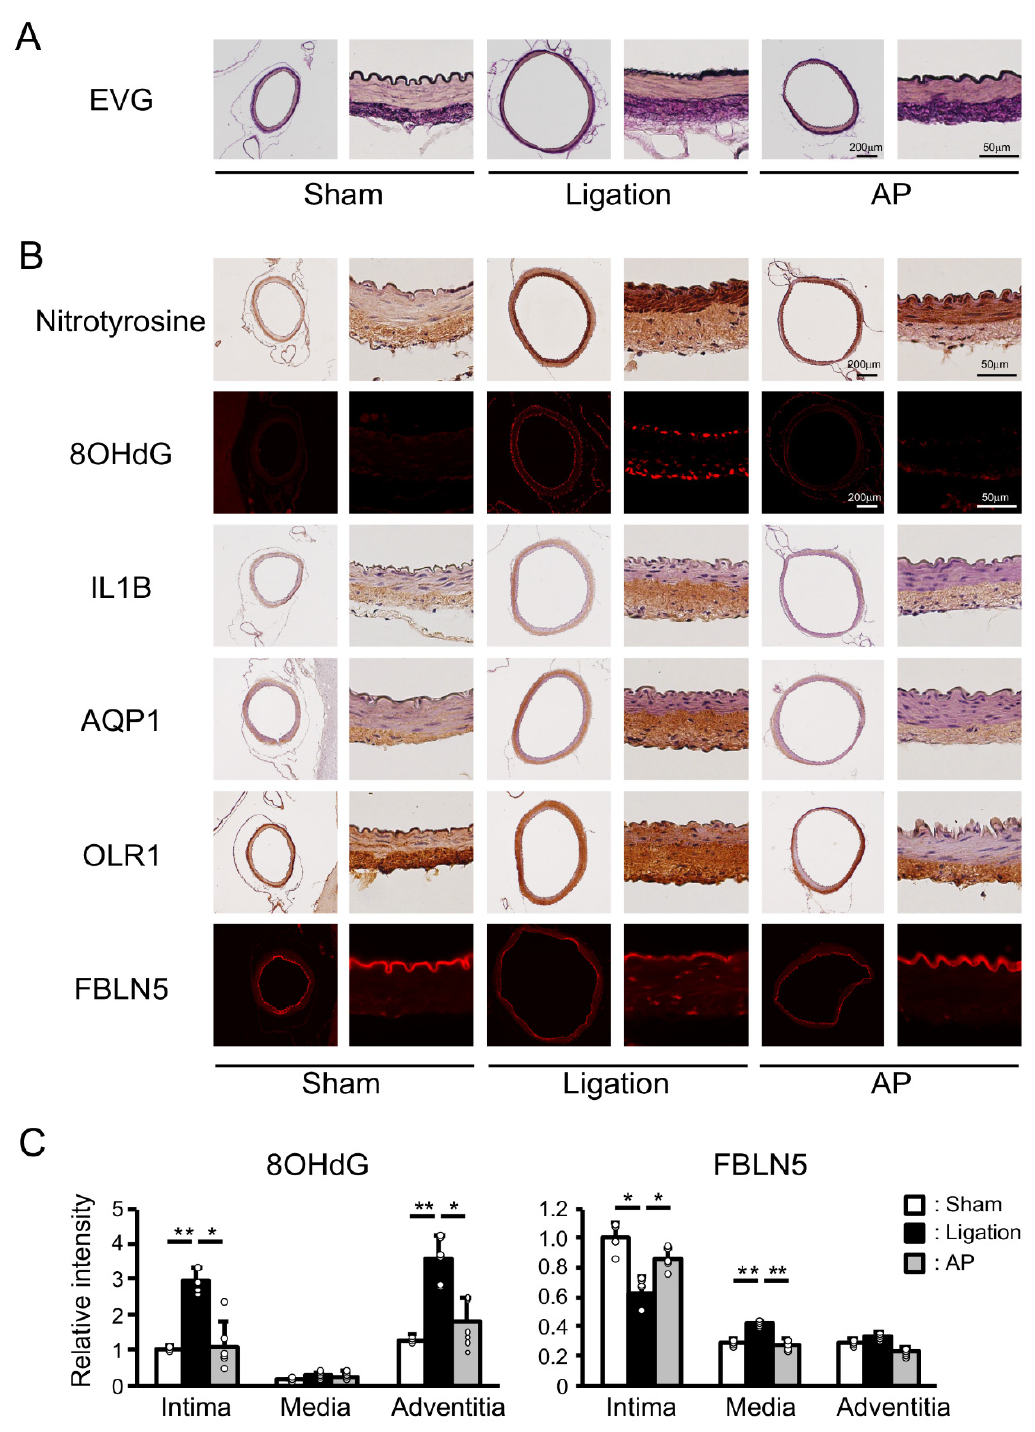
Figure 4. Effect of antioxidant treatment on vascular damage and oxidative stress-related genes in rabbits: ( A ) Representative images of EVG (Elastica van Gieson) staining. AP: apple polyphenol treatment group. ( B ) Representative images of immunostaining of oxidative stress-related genes. 8OHdG: 8-hydroxydeoxyguanosine; IL1B: interleukin 1 β ; AQP1: aquaporin 1; OLR1: oxidized low-density lipoprotein receptor 1; FBLN5: fiburin 5. ( C ) Relative intensity of immunofluorescence staining. n = 4 for Sham group. n = 6 for Ligation and AP group. ** p < 0.01, * p < 0.05.